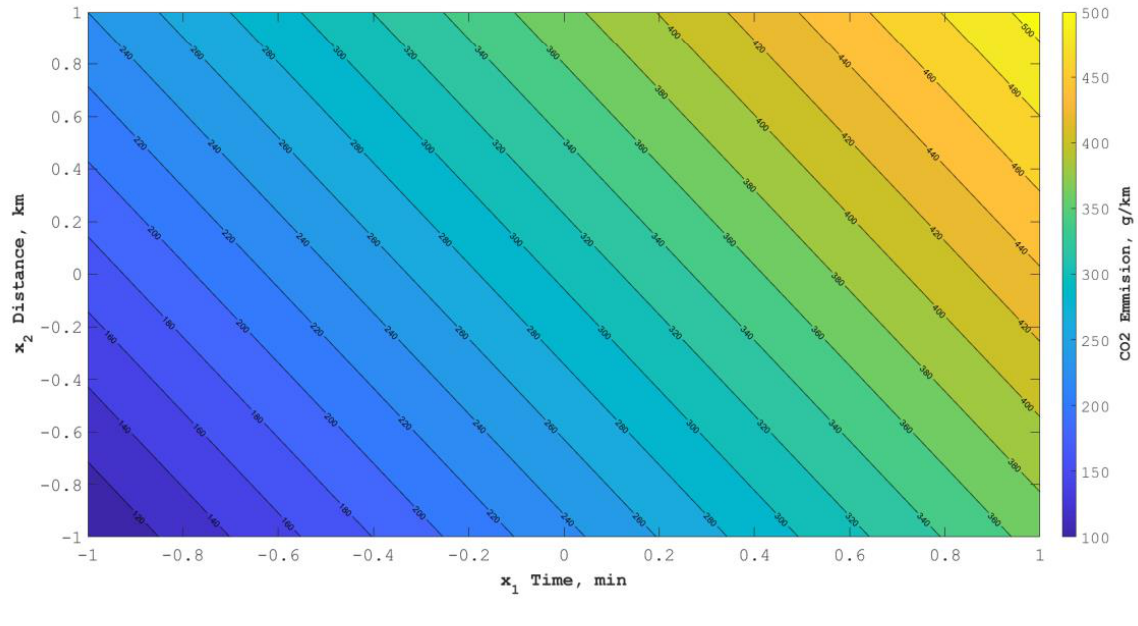
Figure 8. Change in CO 2 emission depending on the variability of factors x 1 and x 2 for a vehicle (ICE) moving at a temperature of 15 °C (x 3 = −1 ).